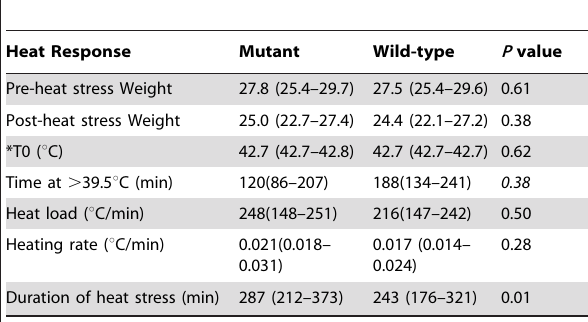
Table 1. Thermal responses in Mutant and Wild-type mice subjected to heat